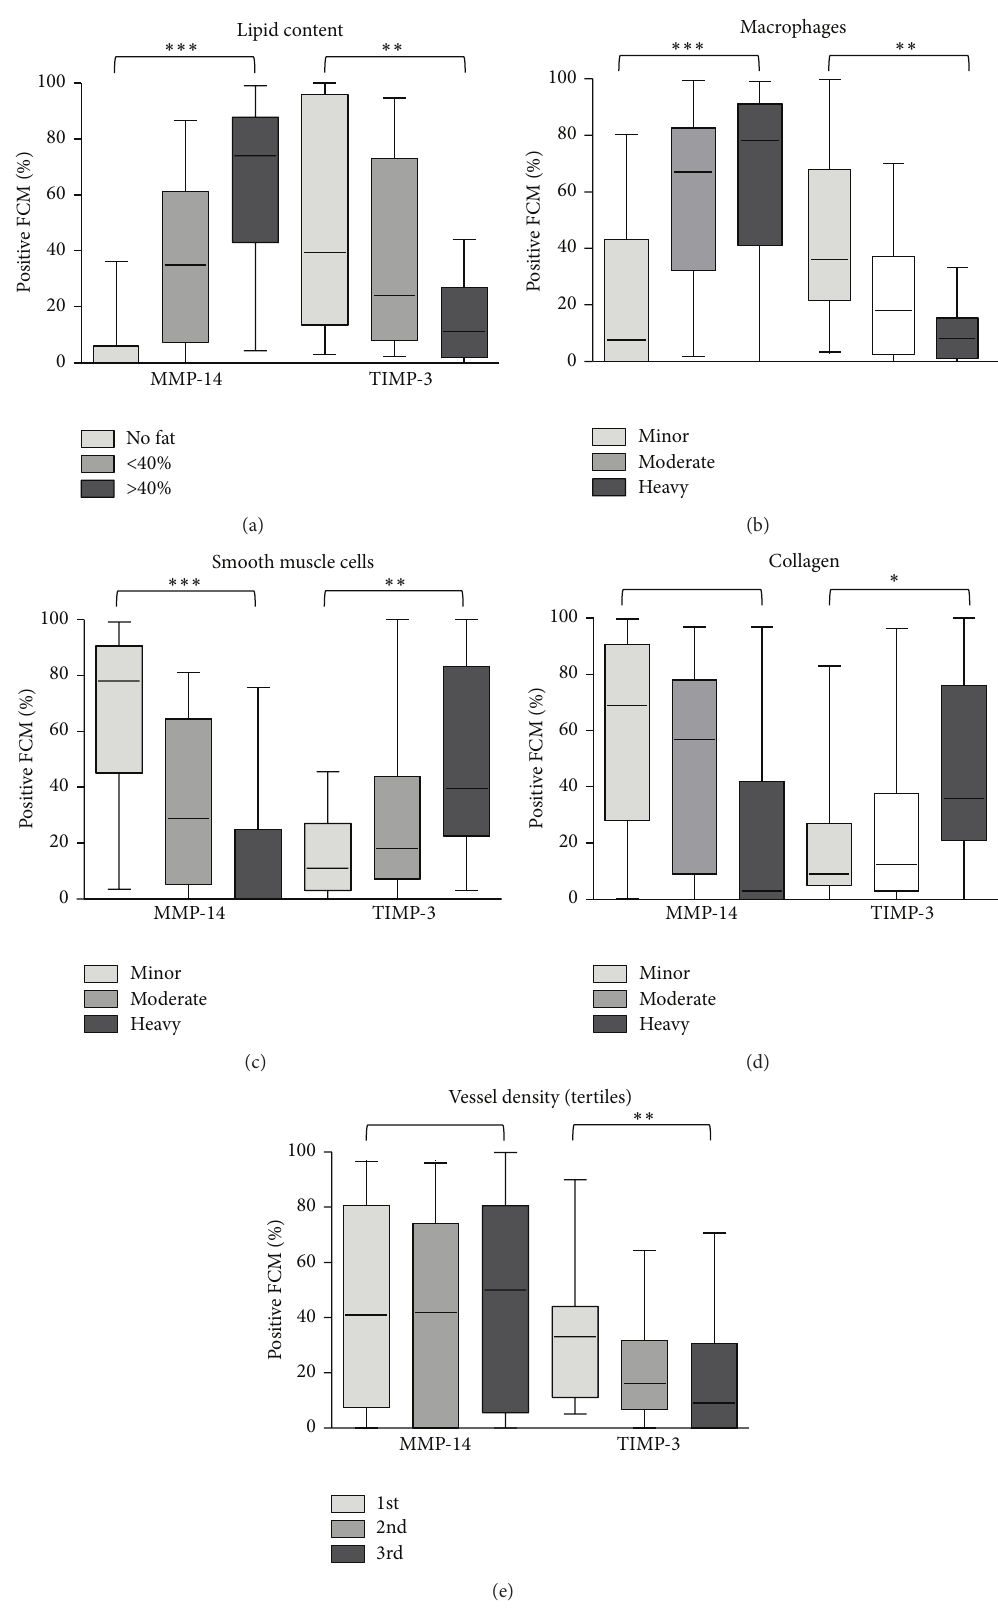
Figure 7: The percentage of MMP-14 and TIMP-3 positive foam-cell macrophages (median [95% confidence limits]) was compared with semiquantitative plaque features and 𝑃 values computed with a Kruskal-Wallis test ( ∗ 𝑃 < 0.05 , ∗∗ 𝑃 < 0.01 , ∗∗∗ 𝑃 < 0.001